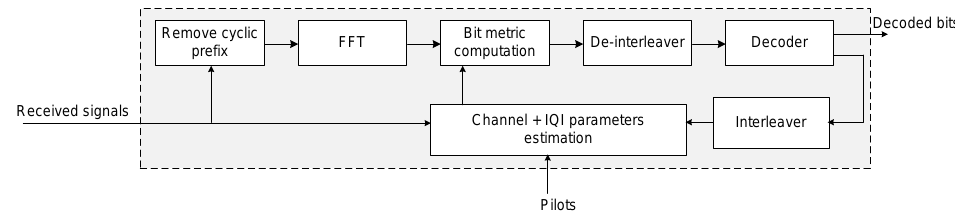
Figure 2. The block diagram of the suggested approach at the